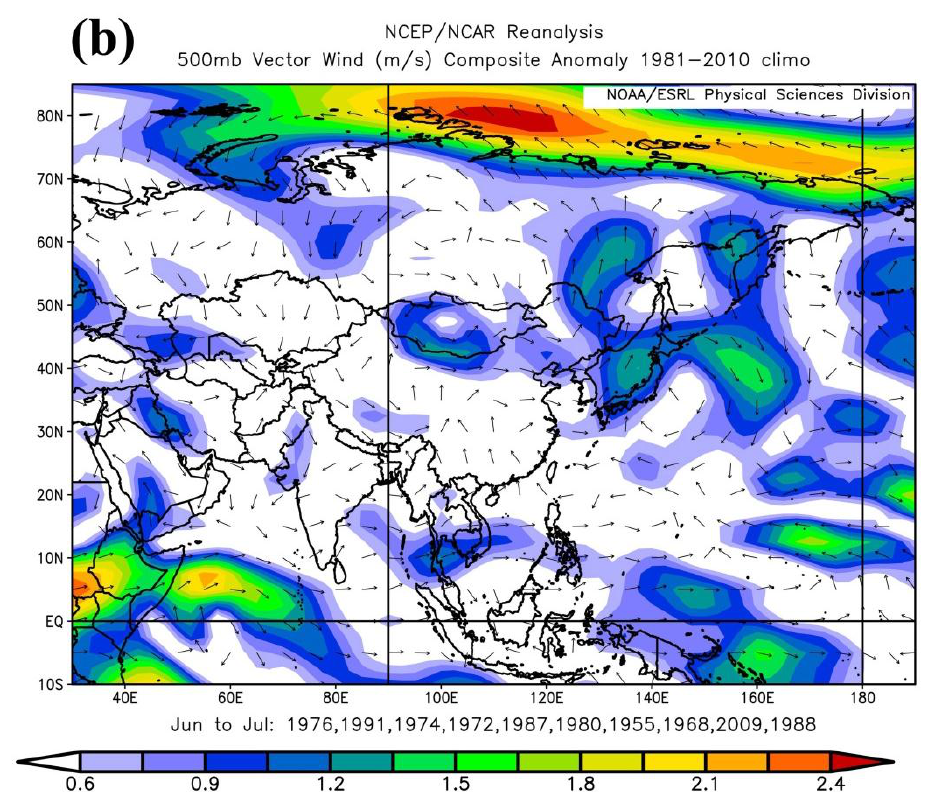
Figure 11. Composite anomaly maps of 500 hPa vector wind (PDSI p6-7 ) for the 10 wettest ( a ) and 10 driest ( b ) years for the northern Daxing’anling Mountains of Inner Mongolia during the period 1948–2018.